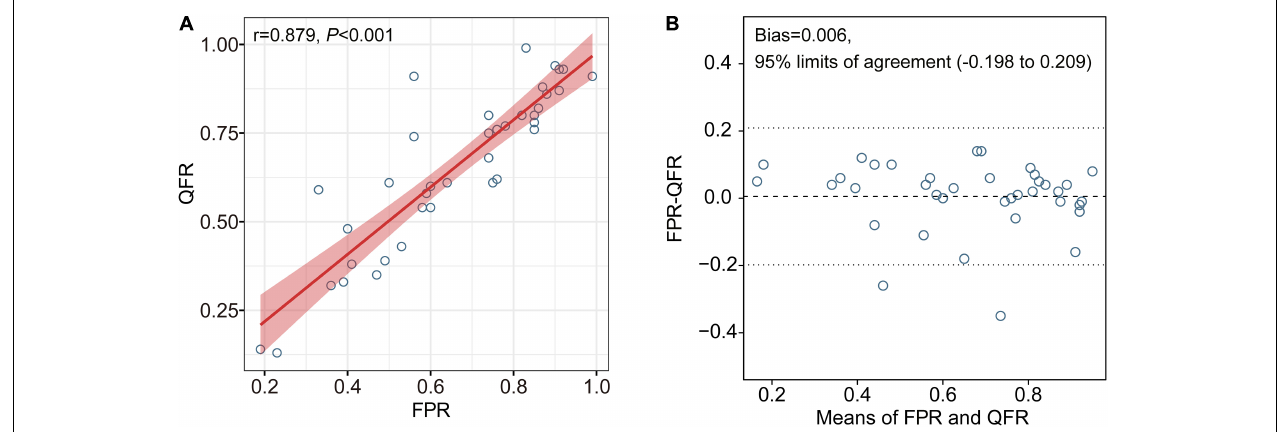
FIGURE 2 | Correlation and agreement between QFR and FPR. Excellent correlation and agreement were observed between QFR and FPR ( A , B , respectively). FPR, fractional pressure ratio; QFR, quantitative flow ratio.